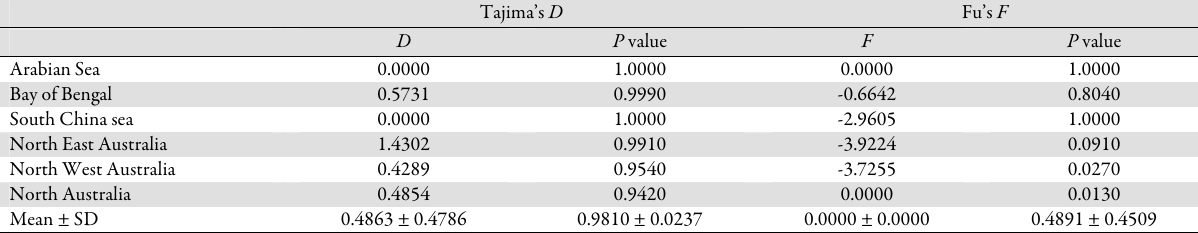
Table 5. Statistical tests for neutrality for E. tetradactylum based on mitochondrial COI sequence data